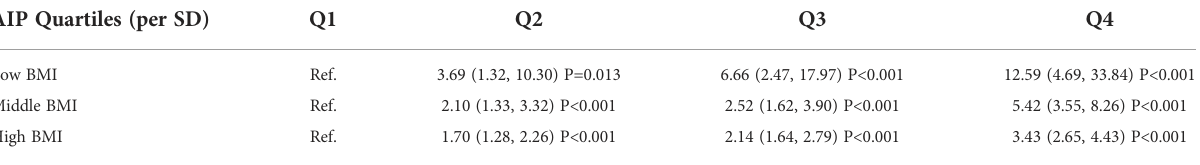
Model was adjusted for all covariates in Model 3 except BMI